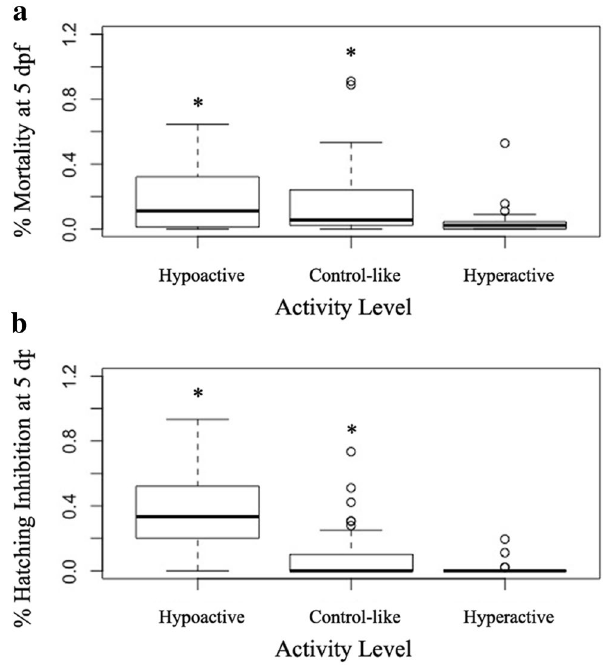
Figure 5. Box plot representing ( a ) % mortality and ( b ) % hatching inhibition at 5dpf after a 1:1 sample/egg water exposure relative to 100% egg water control. Data is plotted based upon samples that significantly induced hypoactivity, hyperactivity, or no significance from egg water controls. Additional information regarding specific samples that induced significant hyper or hypoactivity can be found in Table S1, p value < 0.05, ANOVA, n =